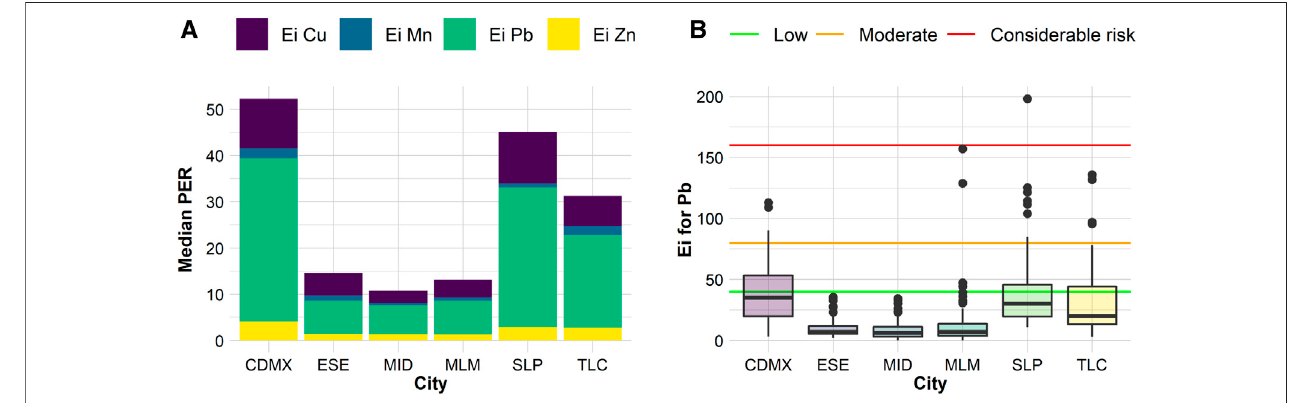
FIGURE 3 | In the (A) , the value of the median potential ecological risk (PER), divided according to the contribution of each of the metals risk factors (Ei). In the (B) , box plots of lead risk factors (Ei) for each studied city. CDMX: Mexico City, ESE: Ensenada, MID: Mérida, MLM: Morelia, SLP: San Luis Potosí, TCL: